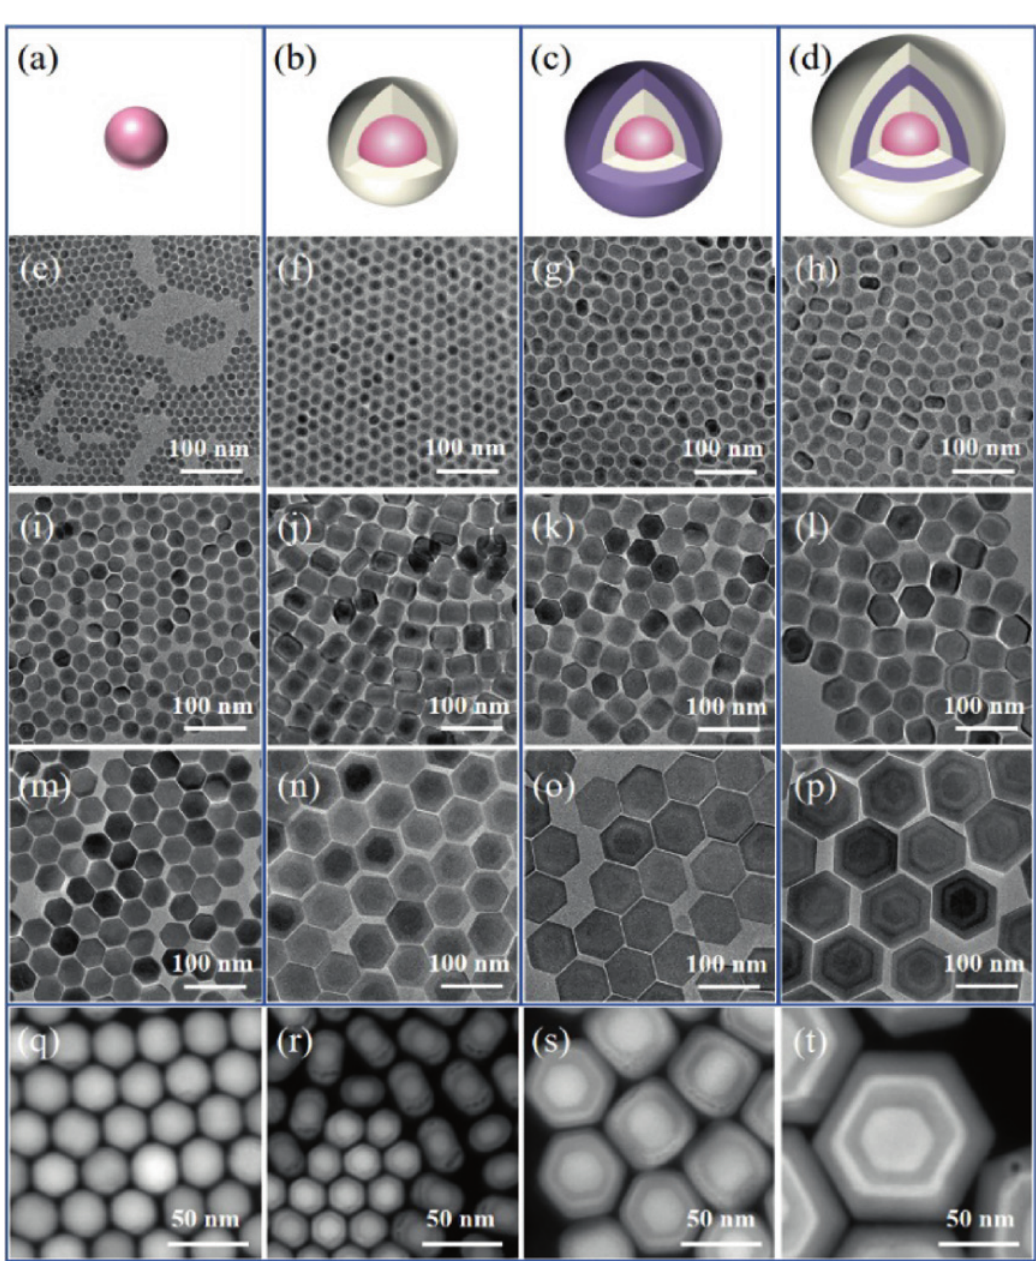
Figure 1: (a – d) are schematic illustration of the core (C), core/shell (CS), core/dual-shell (CSS) and core/triple-shell (CSSS) via successive layer-by-layer growthstrategy.(e, i,m), (f,j, n),(g, k,o), and(h, l,p) are theC, CS, CSS,andCSSS NCswith differentsizes,respectively.(q) – (t) are the HAADF-TEM images corresponding to the products shown in (i), (h), (l), and (p),